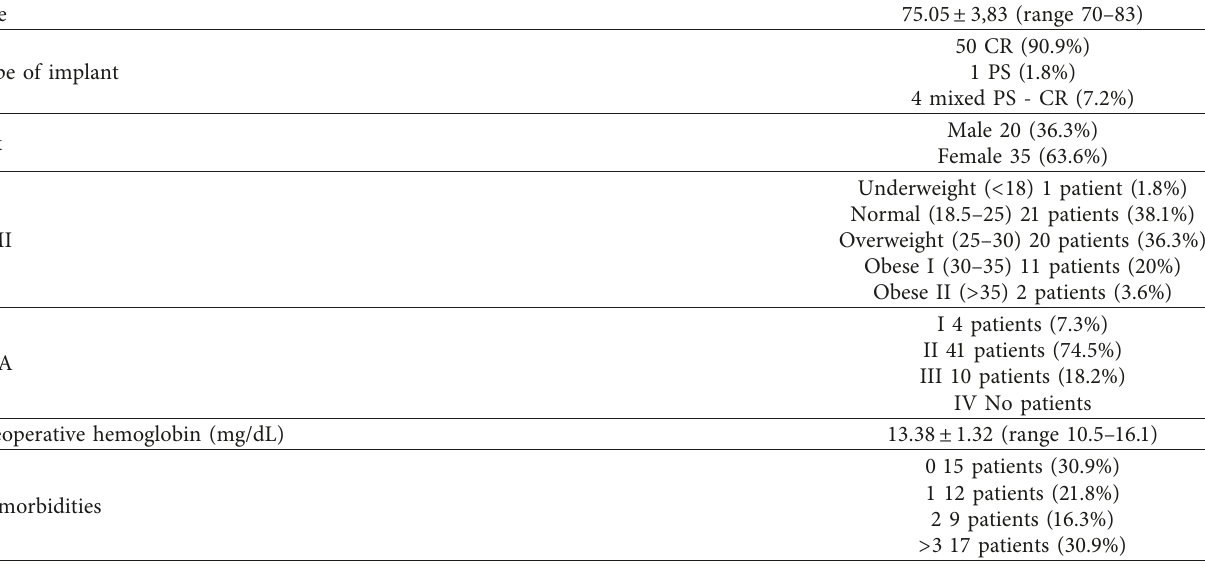
Table 1: Patients’ data.